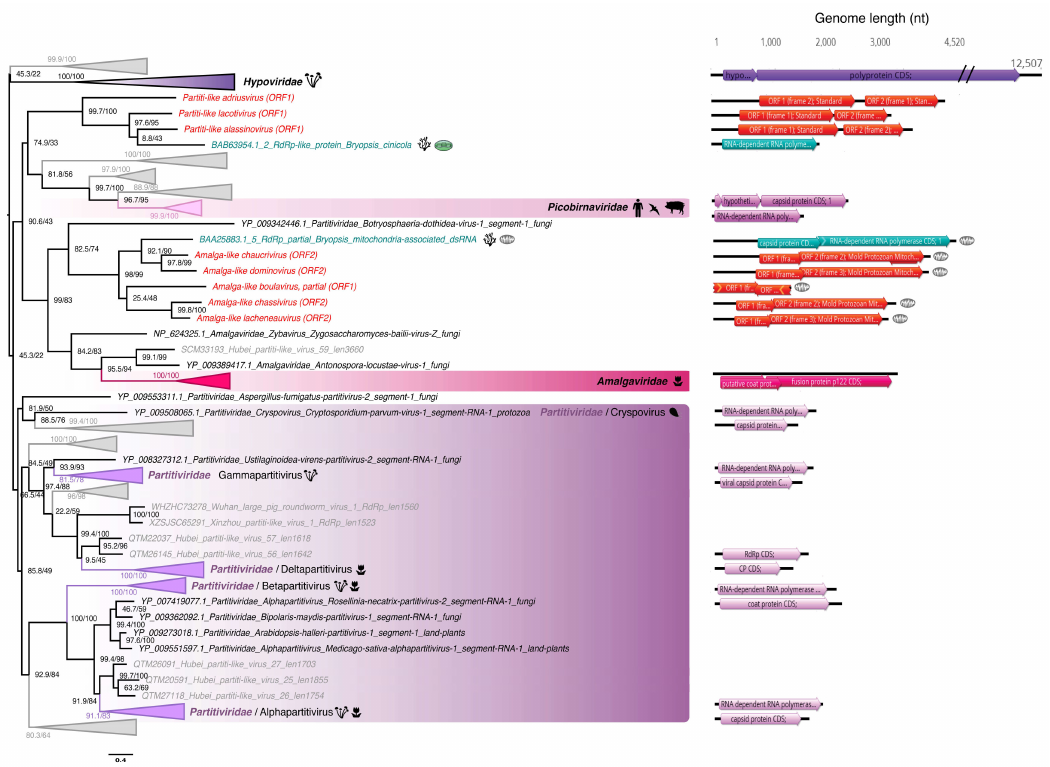
Figure 3. RdRp phylogeny of the newly identified chlorophyte viruses among the Amalgaviridae , Partitiviridae , Picobirnaviridae and Hypoviridae . Sequences identified in this study are labeled in red. Unclassified sequences from [65] are highlighted in grey. For clarity, some families and genera have been collapsed. Left, phylogenetic tree estimated using IQ-Tree with bootstrap replicates and SH-aLTR set to 1000 (values in parenthesis). Right, genomic organization of both viral genomes identified in this study (red) and representative species of each major family and genus used in the phylogeny (